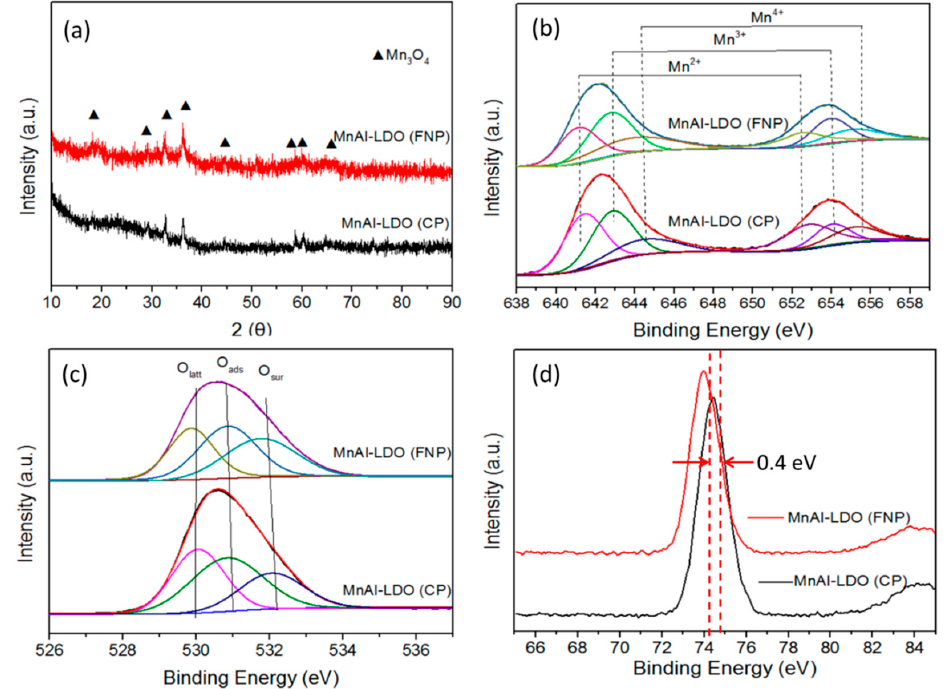
Figure 3. ( a ) XRD patterns of the MnAl-LDO (CP) and MnAl-LDO (FNP) catalysts; ( b ) Mn 2p; ( c ) O 1s and ( d ) Al 2p XPS spectra of the MnAl-LDO (CP) and MnAl-LDO (FNP) catalysts.